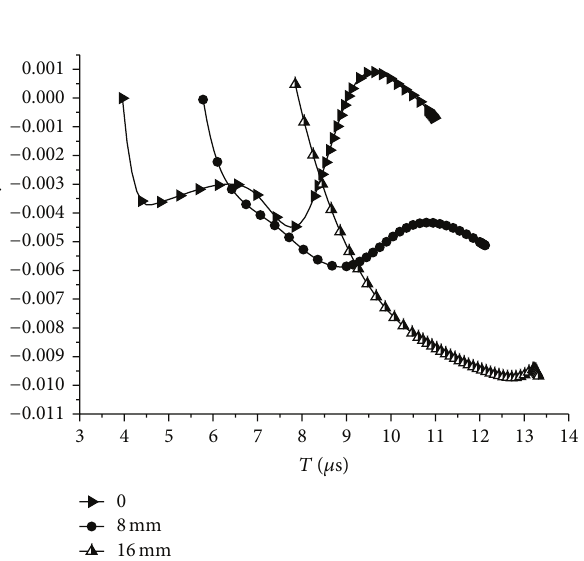
Figure 2: Experimental stress-time curves.